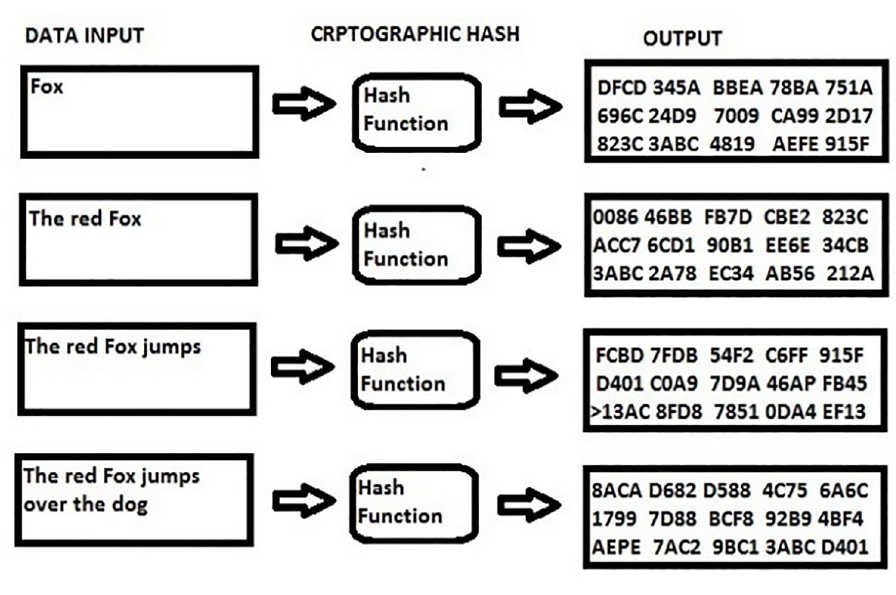
Fig 1. Cryptographic hash